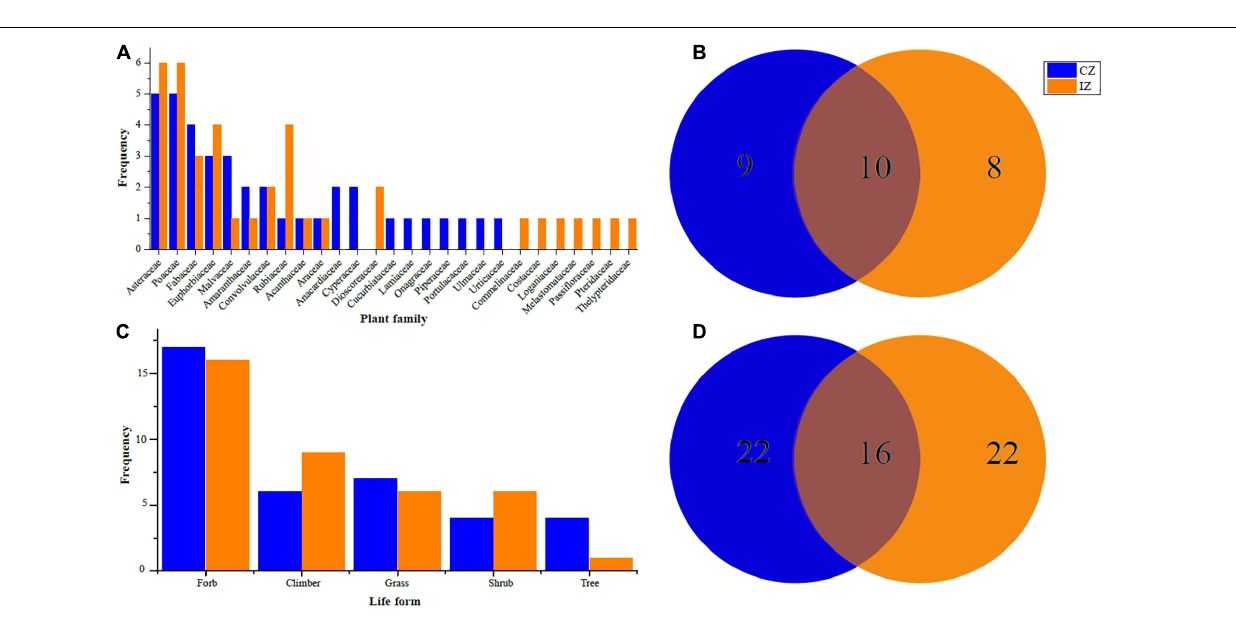
CZ were as follows: Dominance index (0.36), Simpson